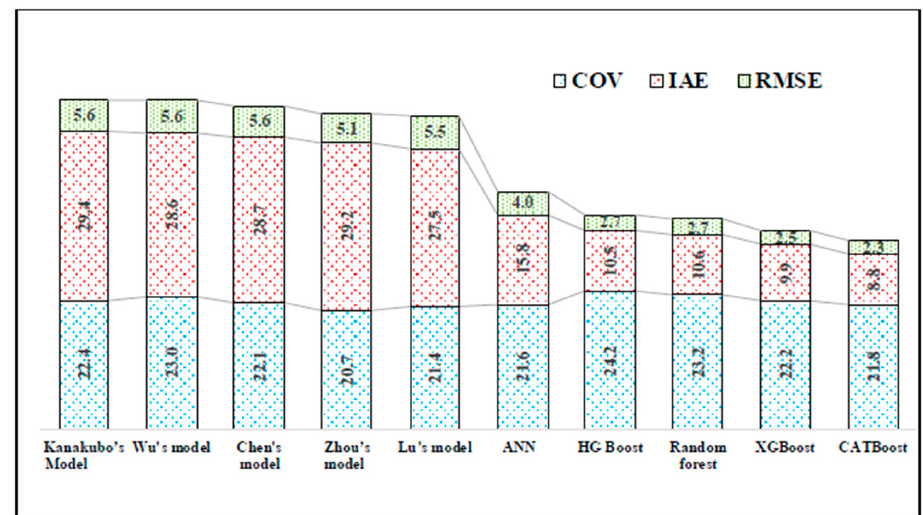
Figure 9. Error evaluation comparison.